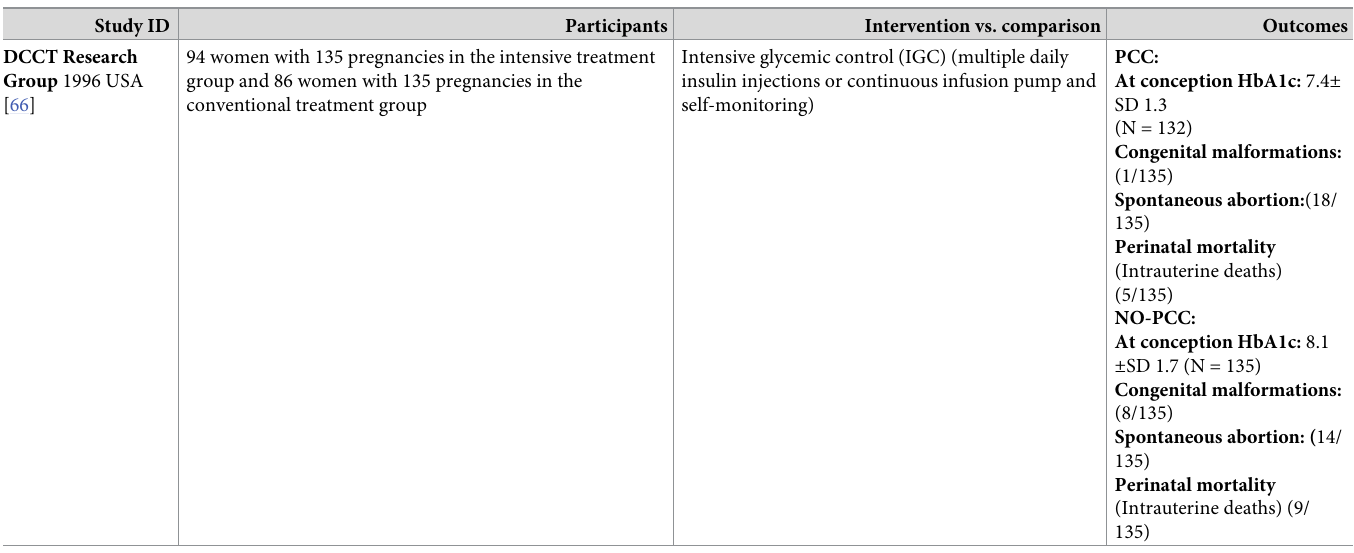
Table 3. Characteristics of included RCT studies.